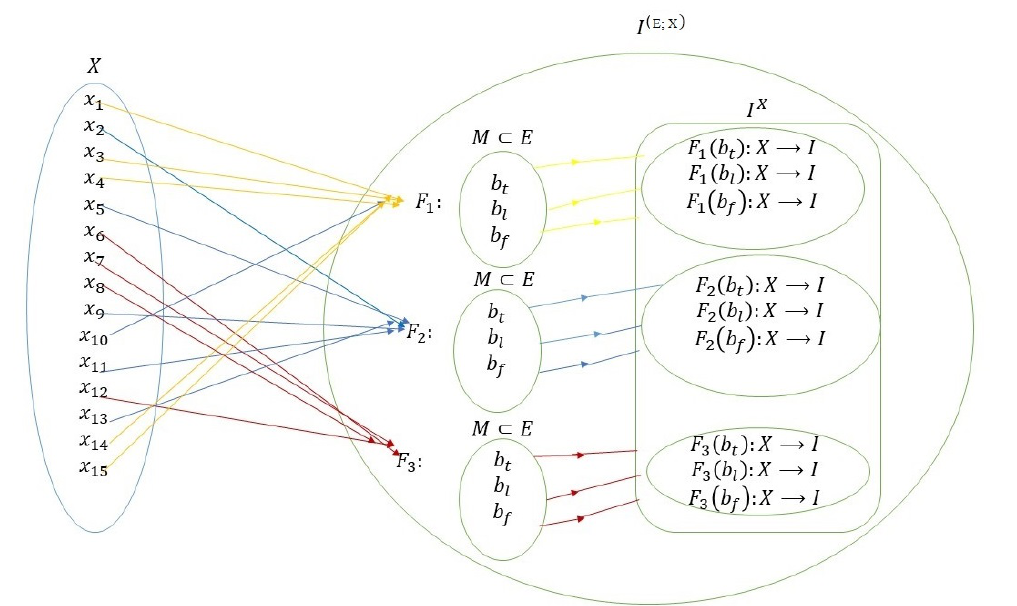
Figure 3. Pictorial representation of fuzzy soft set-valued maps in Example 1.